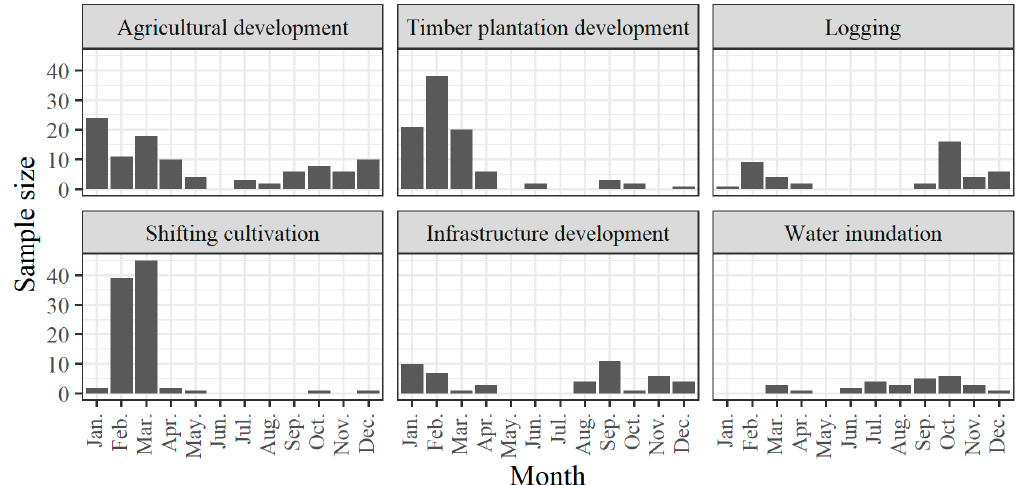
Figure 5. Distribution of samples that experienced disturbance in reference samples. We classified these disturbances for six disturbance agents.